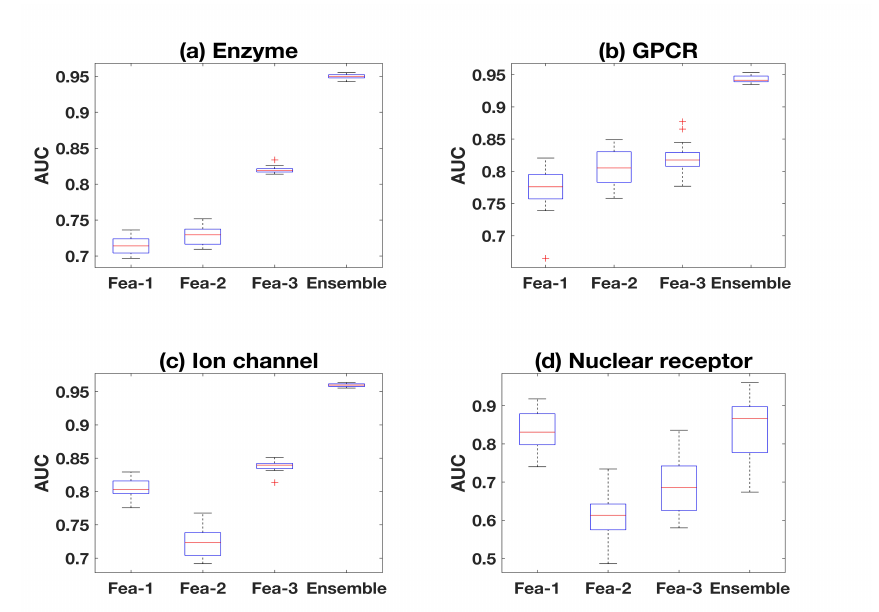
Figure 5. Heatmap of various weights.